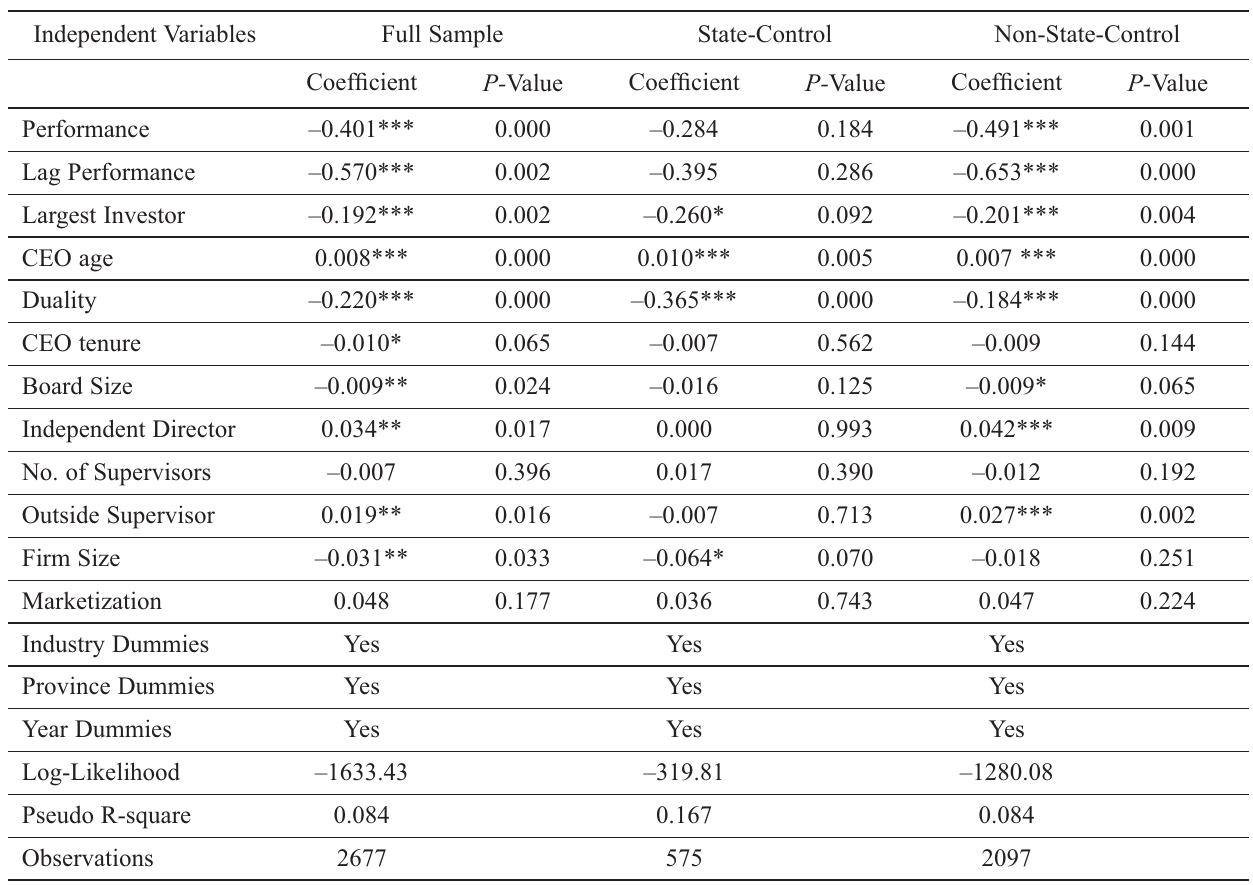
Table 6. Relative performance evaluation (RPE) and CEO turnover at the publicly listed fi rms in China The models are estimated using fi rm-level data of the fi rms listed on the Shanghai or Shenzhen stock exchanges in China during the period 1999–2002. State-control fi rms are fi rms of which the state is the largest shareholder, while non-state- control fi rms are fi rms of which the state is not the largest shareholder. The dependent variable, CEO turnover, equals